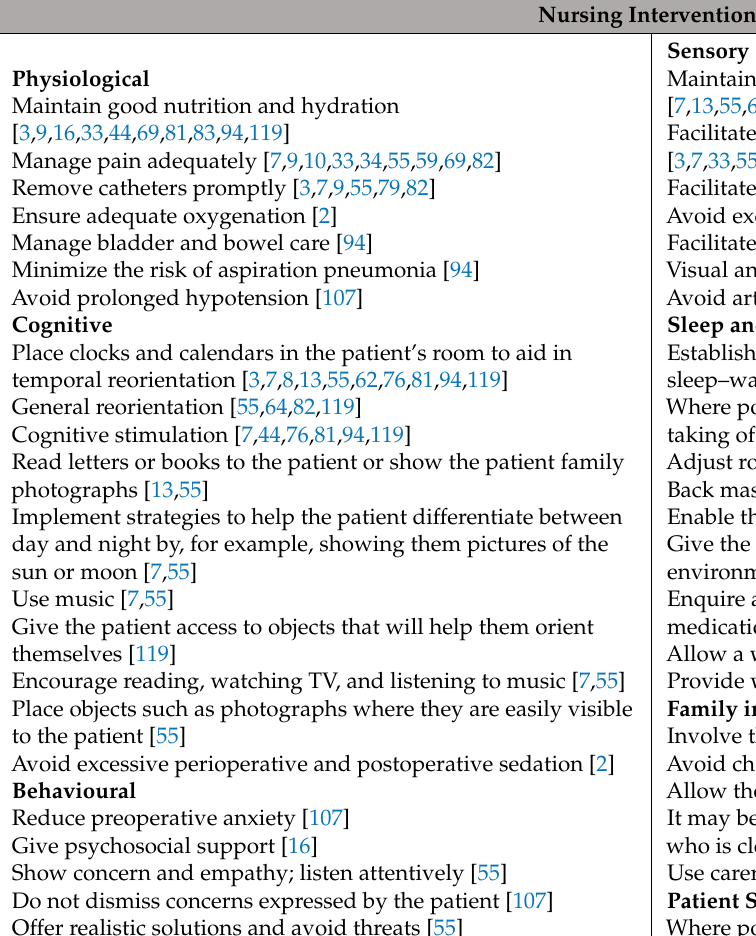
Table 3. Nursing interventions to reduce postoperative delirium.